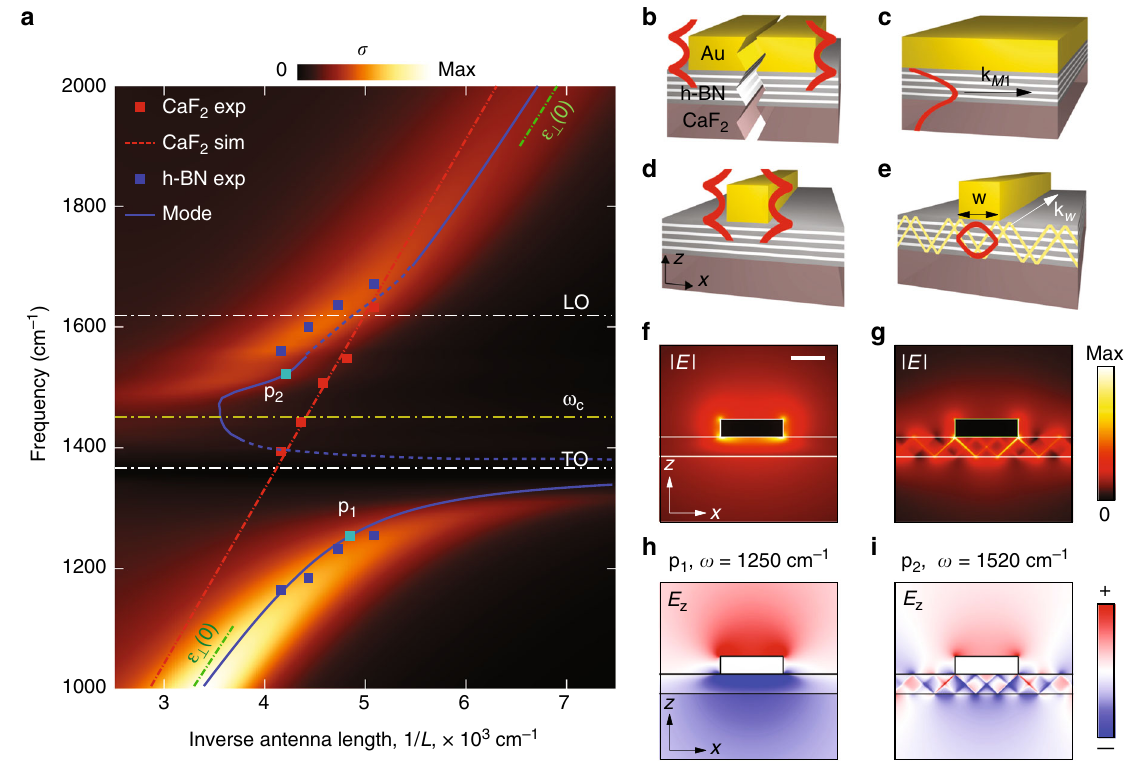
Fig. 2 Infrared spectra of the gold rod antennas over h-BN slab for different antenna lengths and the mode analysis. a Colorplot: calculated extinction cross- section, σ , for the gold antenna on h-BN/CaF 2 as a function of ω and 1/ L . Symbols: maxima in the measured difference transmission spectra for the antennas on h-BN/CaF 2 (blue squares) and on CaF 2 (red squares). Blue solid and red dashed lines represent the dispersion of the mode for the in fi nite Au waveguide (with the cross-section of the antenna) on h-BN/CaF 2 and on CaF 2 , respectively. The dashed parts of the blue curve (where as proper simulation of the dispersion was cumbersome) are a guide to the eye. Green dashed lines represent the asymptotes of the dispersion of the waveguiding mode. b – e Schematics of the in fi nite waveguides and the fi elds of the modes: wide Au stripe supporting edge SPP modes in b , h-BN slab below Au fi lm supporting HPhP M1 mode ( c ), narrow Au rod supporting hybridized edge SPP-like mode and HPhP M1-like mode in d , e , respectively. The modes in d , e originate from the modes in b , c , respectively. f – i Simulated spatial fi eld distributions of the modes of the narrow Au rod waveguide at the frequencies corresponding to the points p 1 ( f , h ) and p 2 ( g , i ) on the blue dispersion curve in a . The fi eld distributions in f , h and g , i correspond to the schematics ( d , e ), respectively. Scale bar, 100